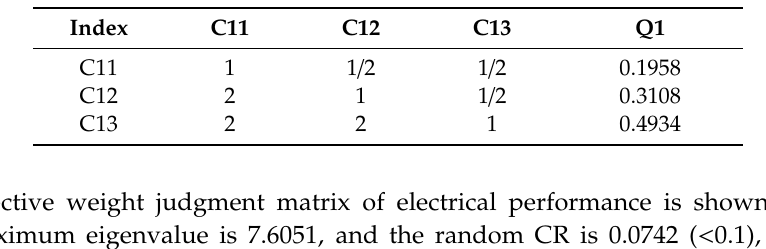
Table 3. Subjective weight of the general performance.